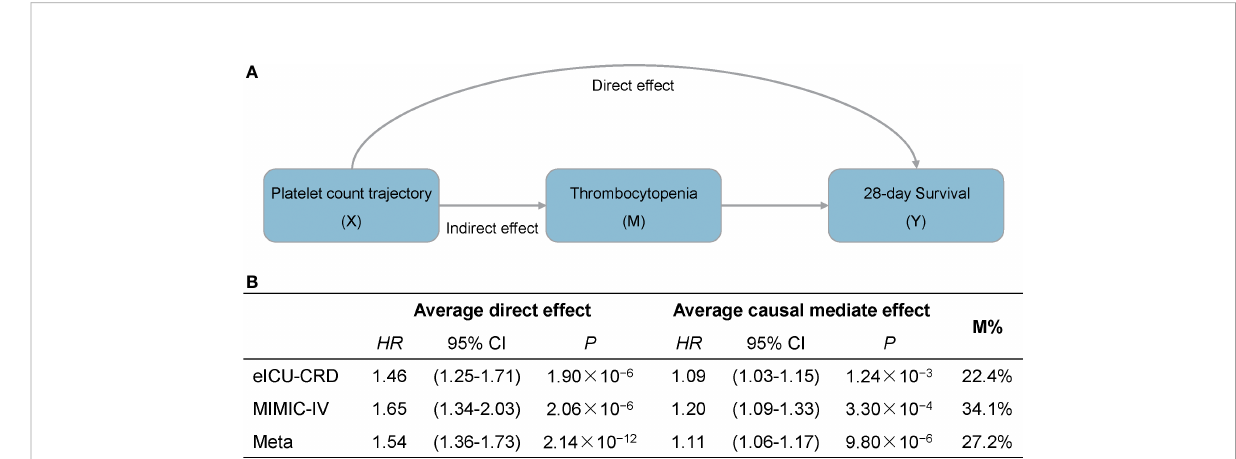
FIGURE 3 Causal mediation analysis for platelet count dynamic trajectory, thrombocytopenia, and 28-day survival. (A) Mediation model for the effect of platelet count dynamic trajectory on 28-day survival through thrombocytopenia. (B) Results are described as average causal mediated effect (indirect hazard ratio), 95% con fi dence interval and the proportion of effect mediated (M%).